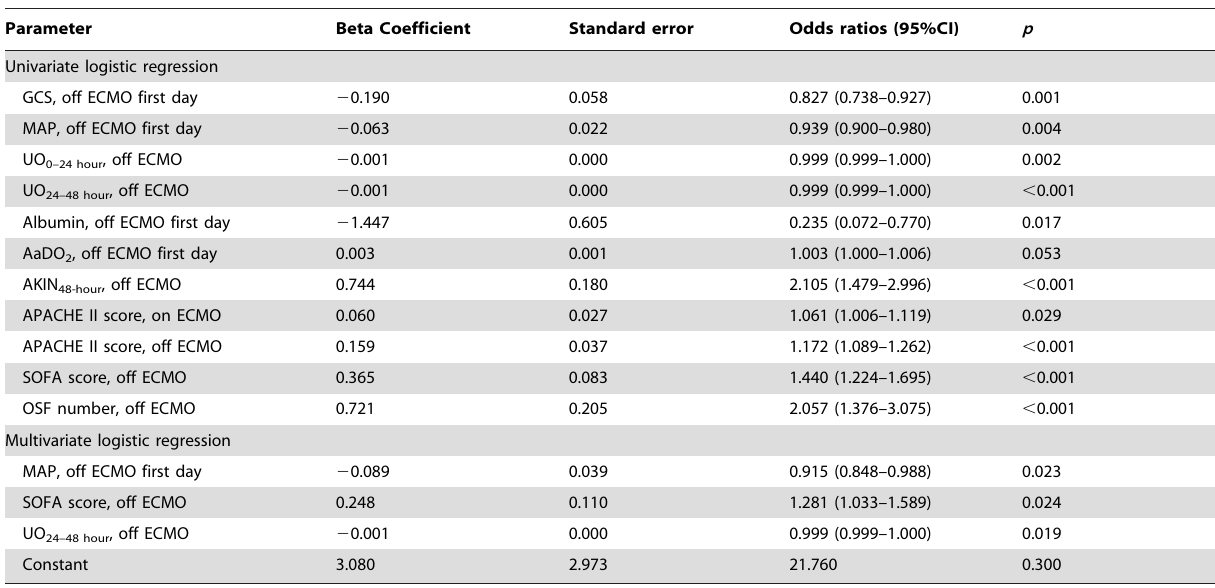
Table 4. Variables showing prognostic significance.